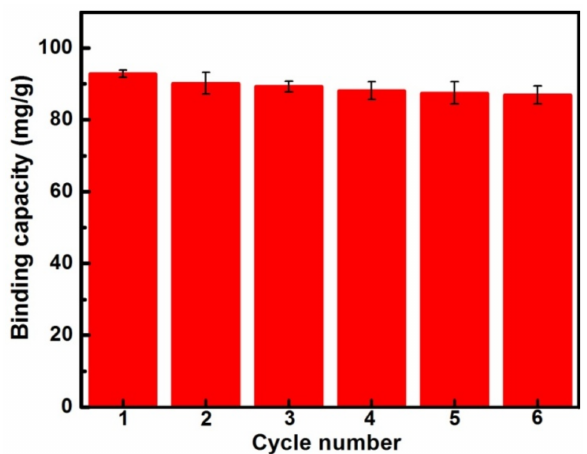
Figure 8. Reusability of MIP prepared with spherical silica (60 µ m) for gossypol adsorption (10 mg of absorbents in 5.0 mL 200 mg · L − 1 gossypol solution for 1